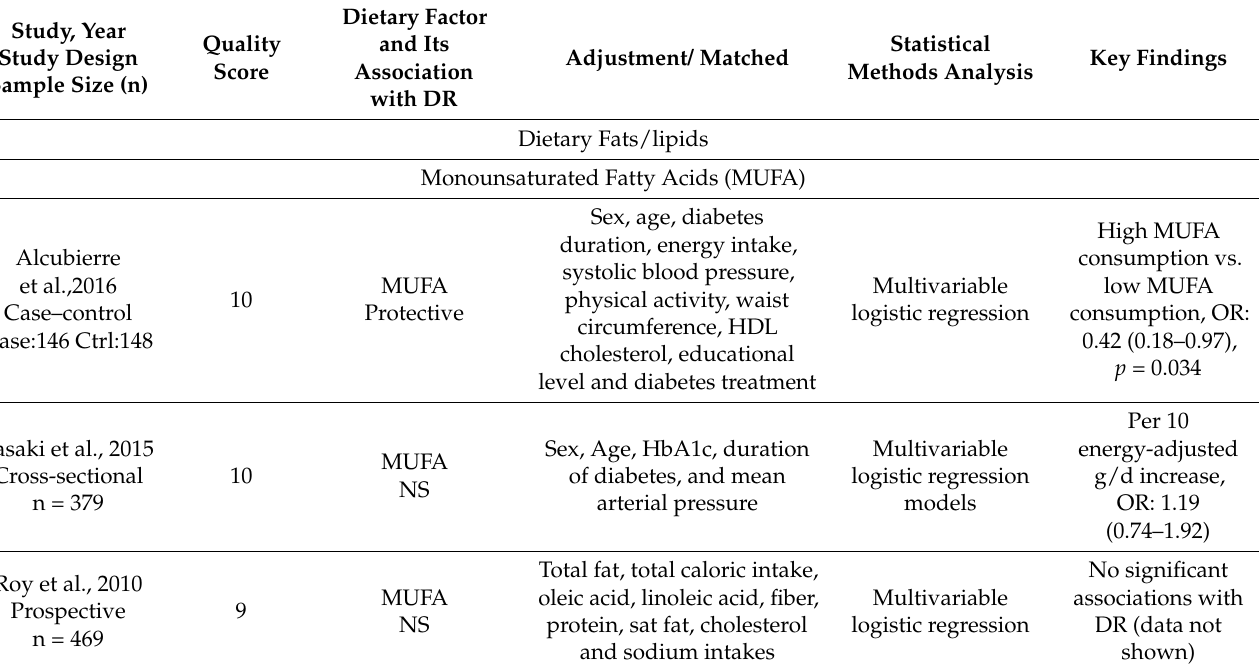
Table 3. Dietary intake of macronutrients and diabetic